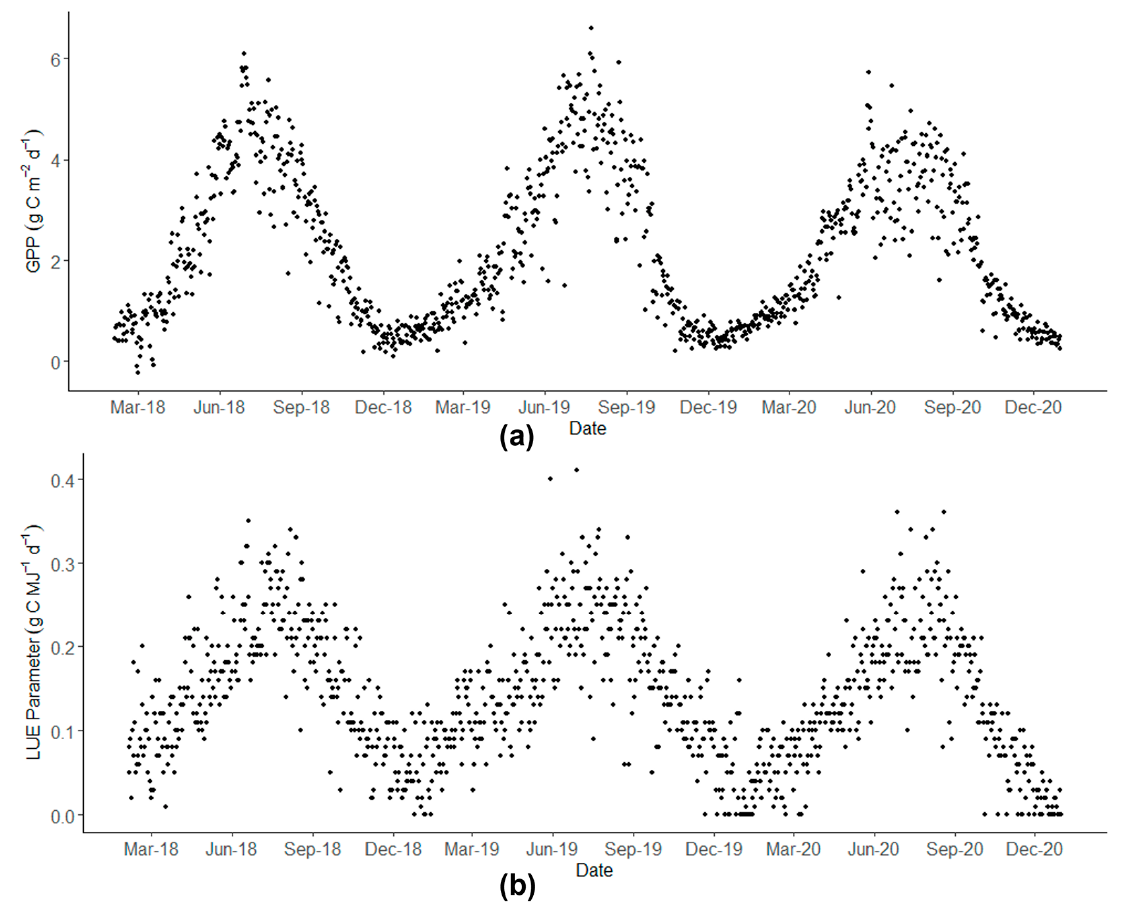
Figure 5. The seasonal temporal dynamics of meteorological parameters: ( a ) Daily gross primary productivity (g C m − 2 d − 1 ) and ( b ) Light use e ffi ciency parameter ( ε site ) (g C MJ − 1 d − 1 ).